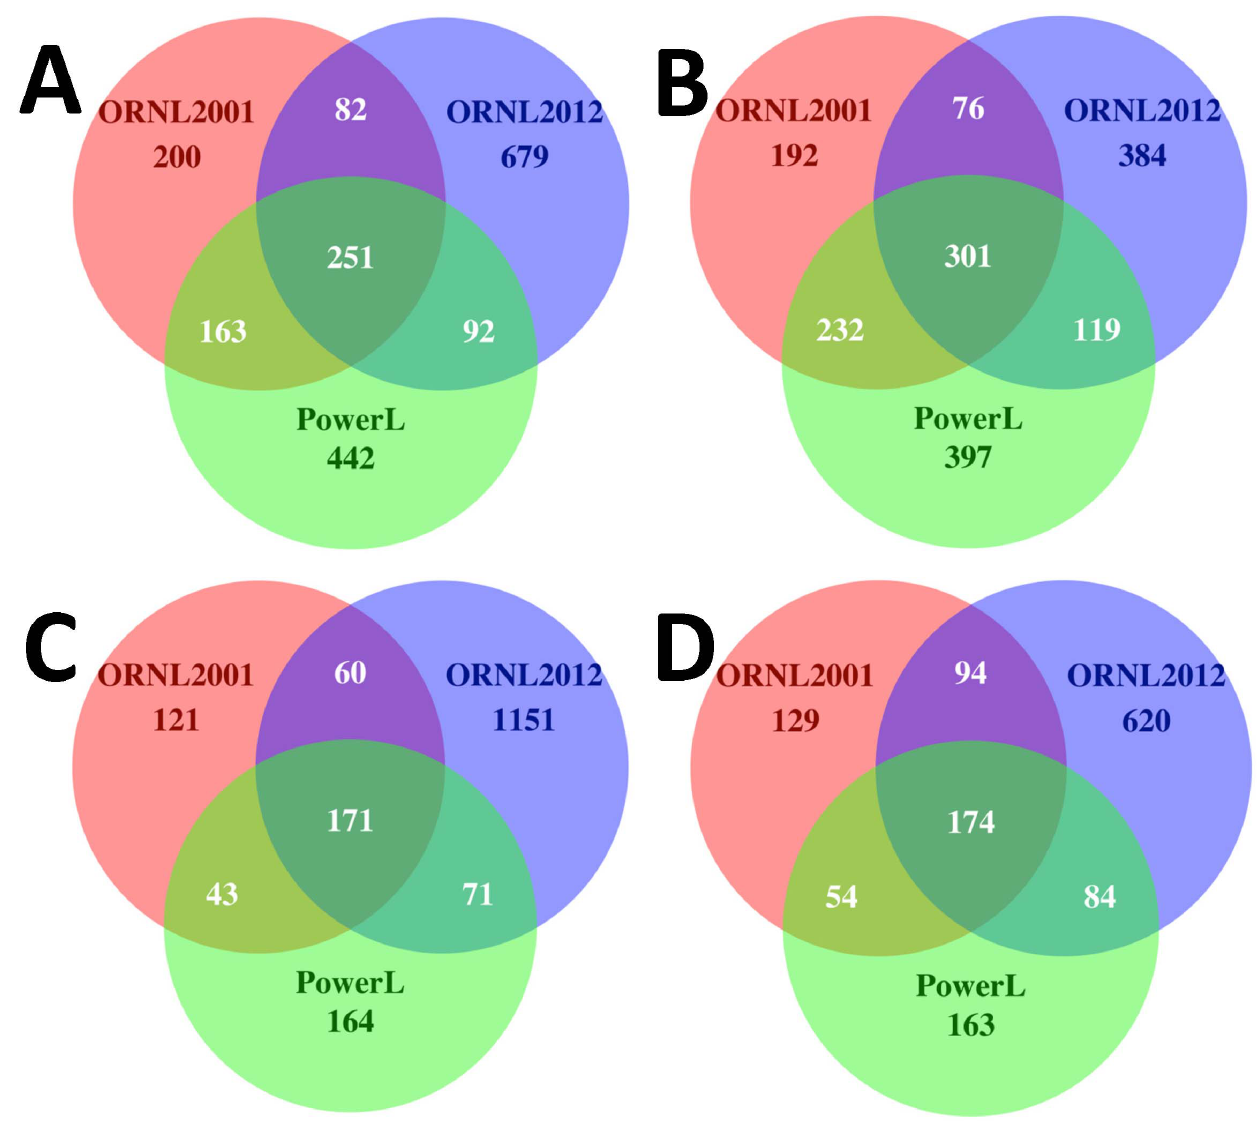
Figure 7. OTU Overlap among DNA Extraction Methods. Venn diagrams representing the combined OTUs accessed using experimental replicate extractions from ( A, B ) deciduous forest A-horizon soil and ( C, D ) iron oxide cemented clay. ( A, C ) The OTUs were identified and clustered using the de novo uclust implementation in QIIME [48] and each sample was rarified to 1499 sequences at 97% sequence similarity from sequences that were de-noised and singletons removed. ( B, D ) Venn diagram of overlapping OTUs across different methods using the closed reference OTU picking method with 97% sequence similarity against manually curated Greengenes database of 16S rRNA sequences.